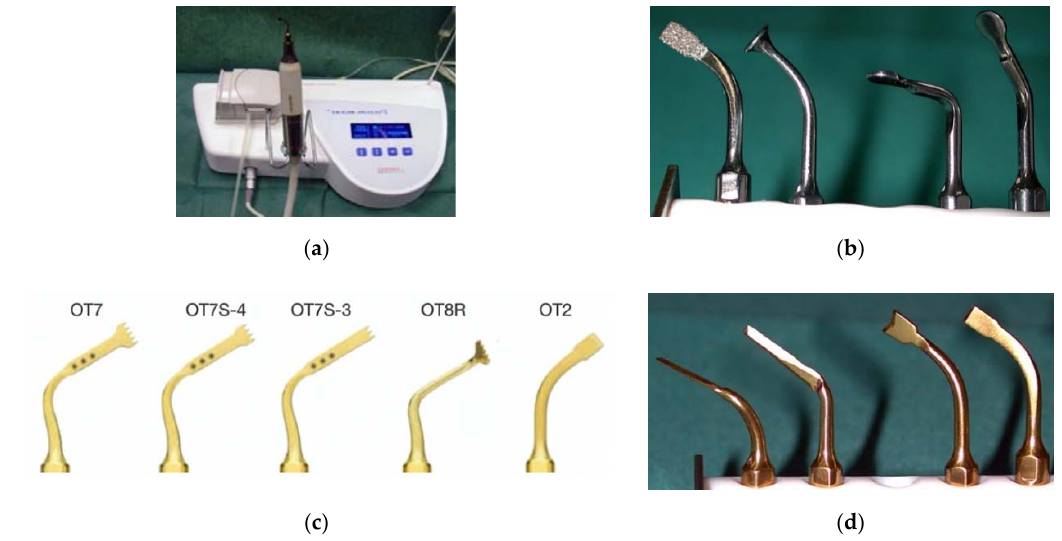
Figure 1. Mectron Piezosurgery ® bone scalpel. Power unit, hand-piece, and irrigation peristaltic module ( a ). Sets of tips ( b – d ).